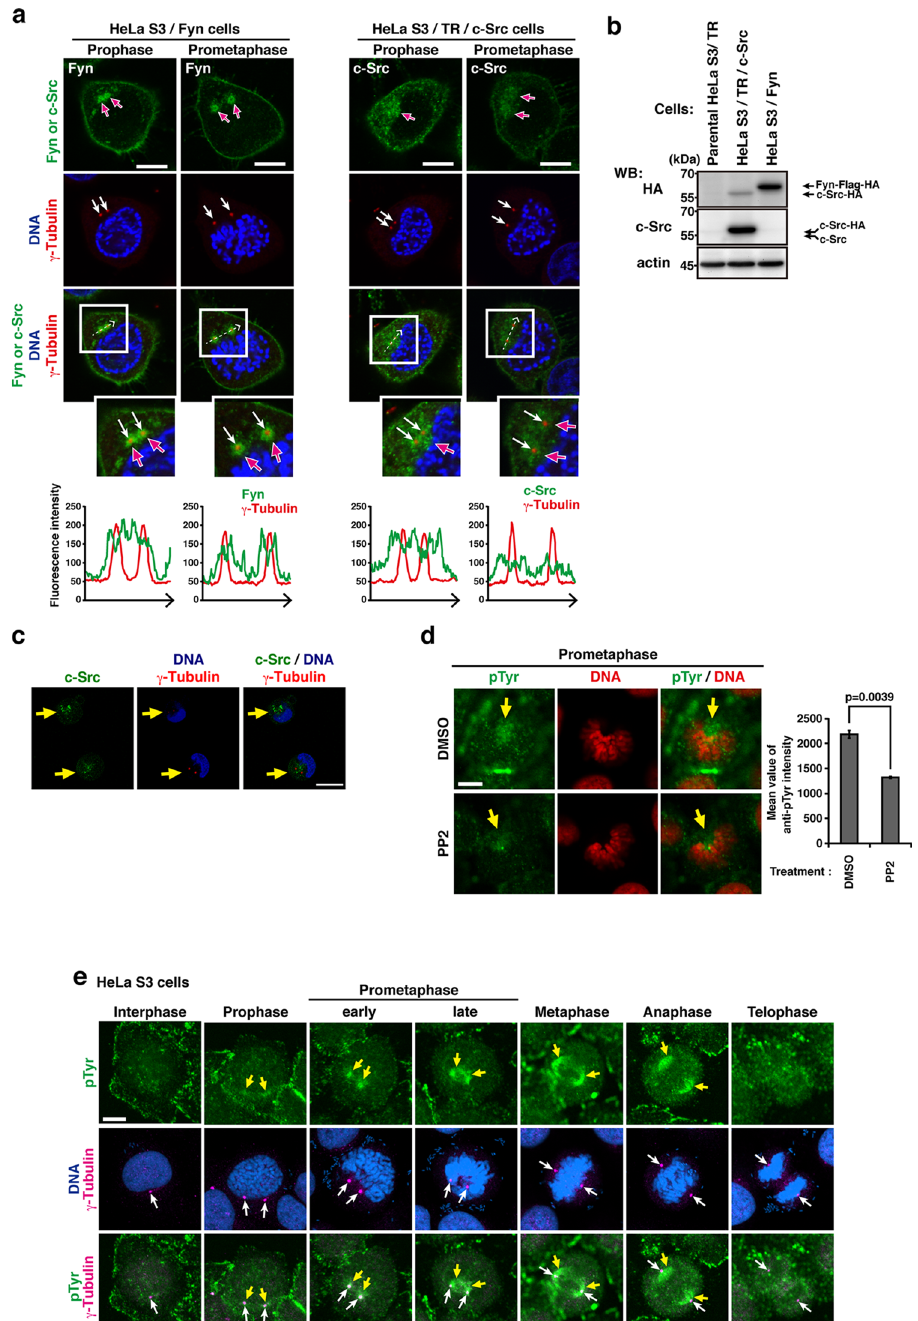
Figure 1. Accumulation of SFKs and tyrosine-phosphorylated proteins in the centrosome during G 2 and M phases. (a) HeLa S3/Fyn or HeLa S3/TR/c-Src cells treated with or without Dox for inducible expression were triply stained for Fyn or c-Src (green), γ-tubulin (red), and DNA (blue). Cells entering the late G 2 and M phases were assessed by chromosome condensation. Scale bars, 10 μm. (b) HeLa S3/TR, HeLa S3/TR/c-Src, or HeLa S3/Fyn cells were treated with or without Dox for inducible expression. A Western blot analysis was conducted using the indicated antibodies. (c) Centrosomal endogenous c-Src cells were triply stained for c-Src (green), γ-tubulin (red), and DNA (blue) in Caco-2 cells. Scale bar, 20 μm. (d) Parental HeLa S3 cells were treated with 20 µM PP2 or 0.1% dimethyl sulfoxide (DMSO, solvent control) for 6 h. Double staining for pTyr (green) and DNA (red) was performed and the fluorescence intensity of pTyr in the centrosome of each cell was quantitated from three independent experiments (n = 121 cells for DMSO, n = 118 cells for PP2 treatment). Bars represent the means ± S.D. of a representative experiment. p values were calculated by the Student’s t -test. Scale bar, 10 μm. (e) Parental HeLa S3 cells were triply stained for pTyr (green), γ-tubulin (red), and DNA (blue). Scale bar, 10 μm. (a,c–e) White, white with red, and yellow arrows indicate the centrosome position, centrosomal Fyn or c-Src accumulation, and endogenous tyrosine-phosphorylated proteins or endogenous c-Src in the centrosome,